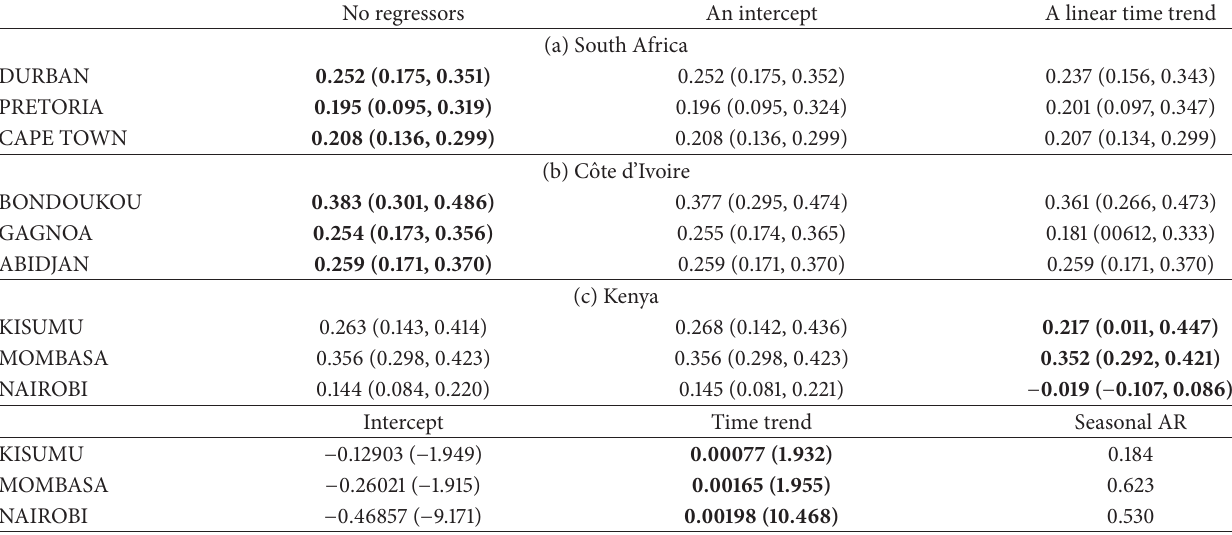
Table 5: Estimates of 𝑑 in the deseasonalized monthly data using a long memory model with AR(1)